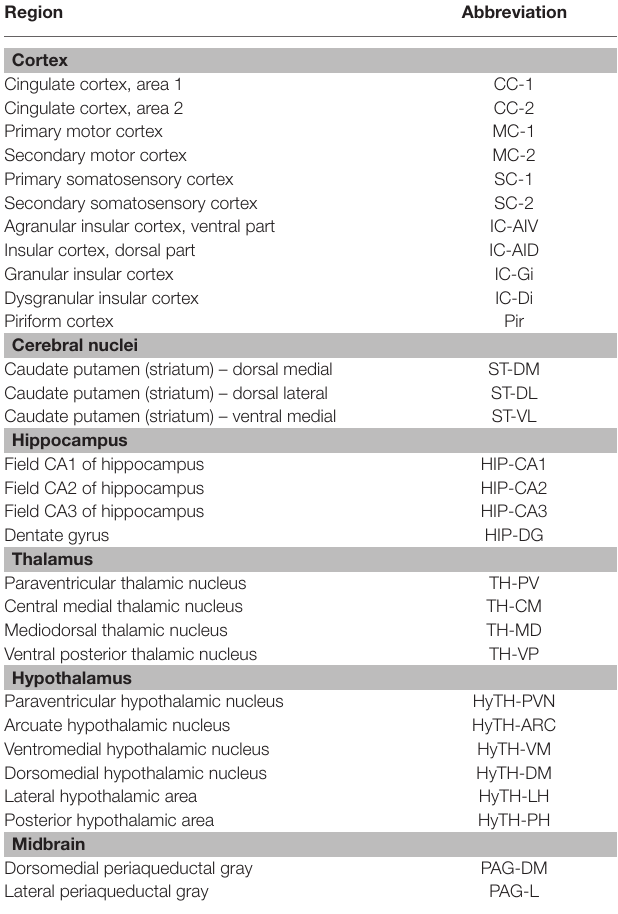
TABLE 1 | Brain region and its abbreviation used in this